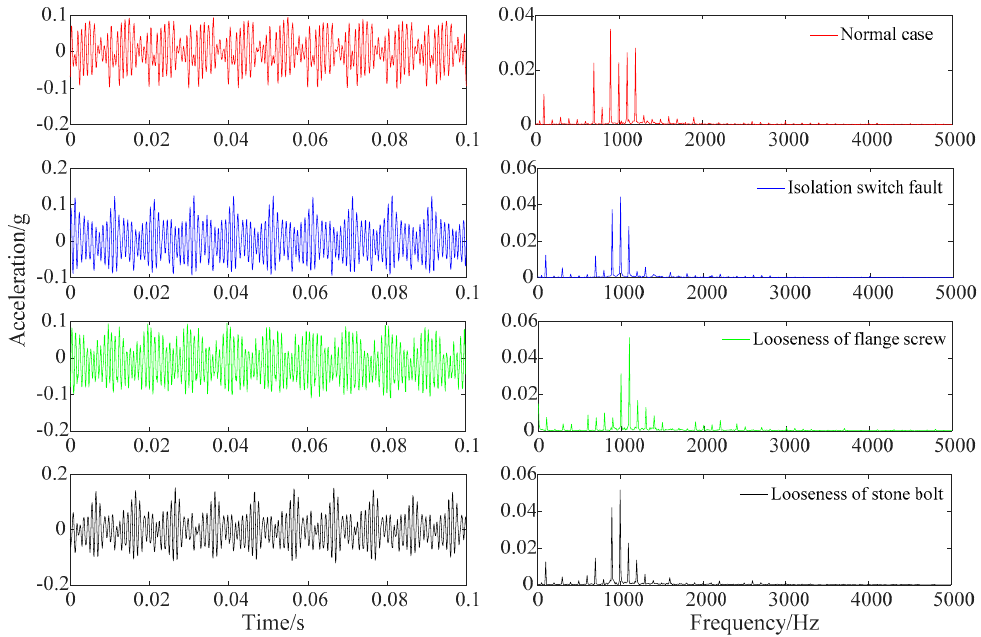
Figure 2. Vibration signal and its spectrum in different working conditions.